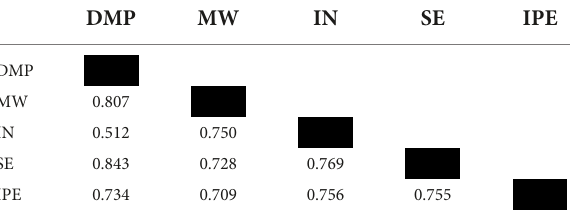
TABLE 4 Discriminant validity—Heterotrait-Monotrait (HTMT).